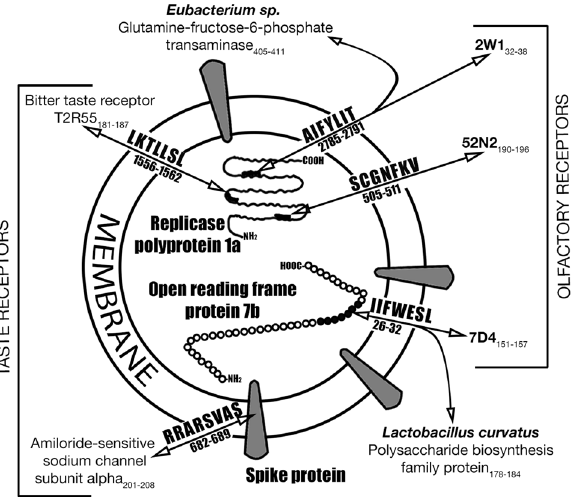
Figure 2. Some SARS CoV-2 hepta/octamers are homologous to human olfactory and taste receptor proteins. Homology to some proteins of commensal gut bacteria is also shown.